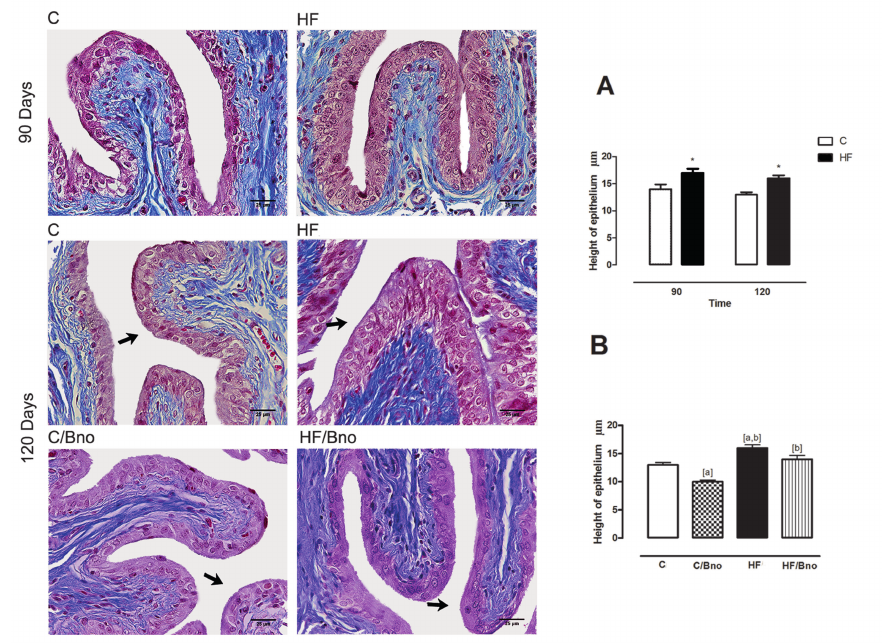
Figure 2 - Image showing the height of the bladder wall epithelium